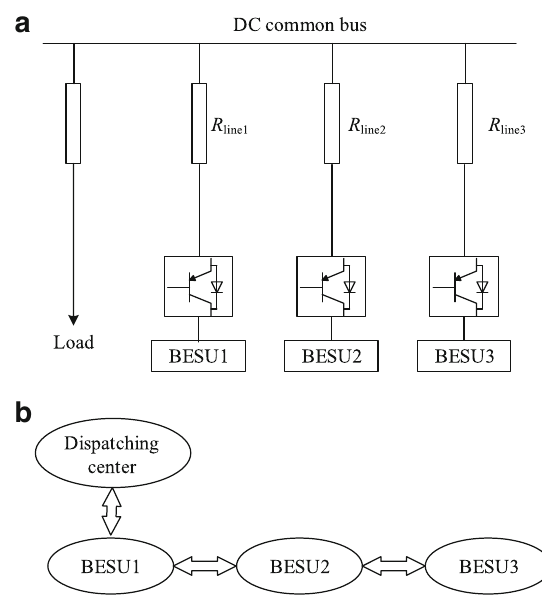
Fig. 5 Configuration and communication topology of DBESS